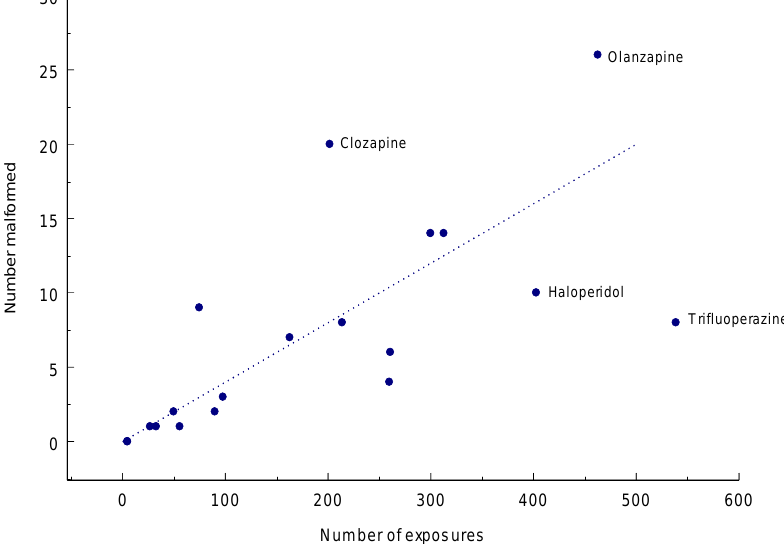
Figure 3. Number of exposures and number of malformations for various antipsychotics according to Gentile